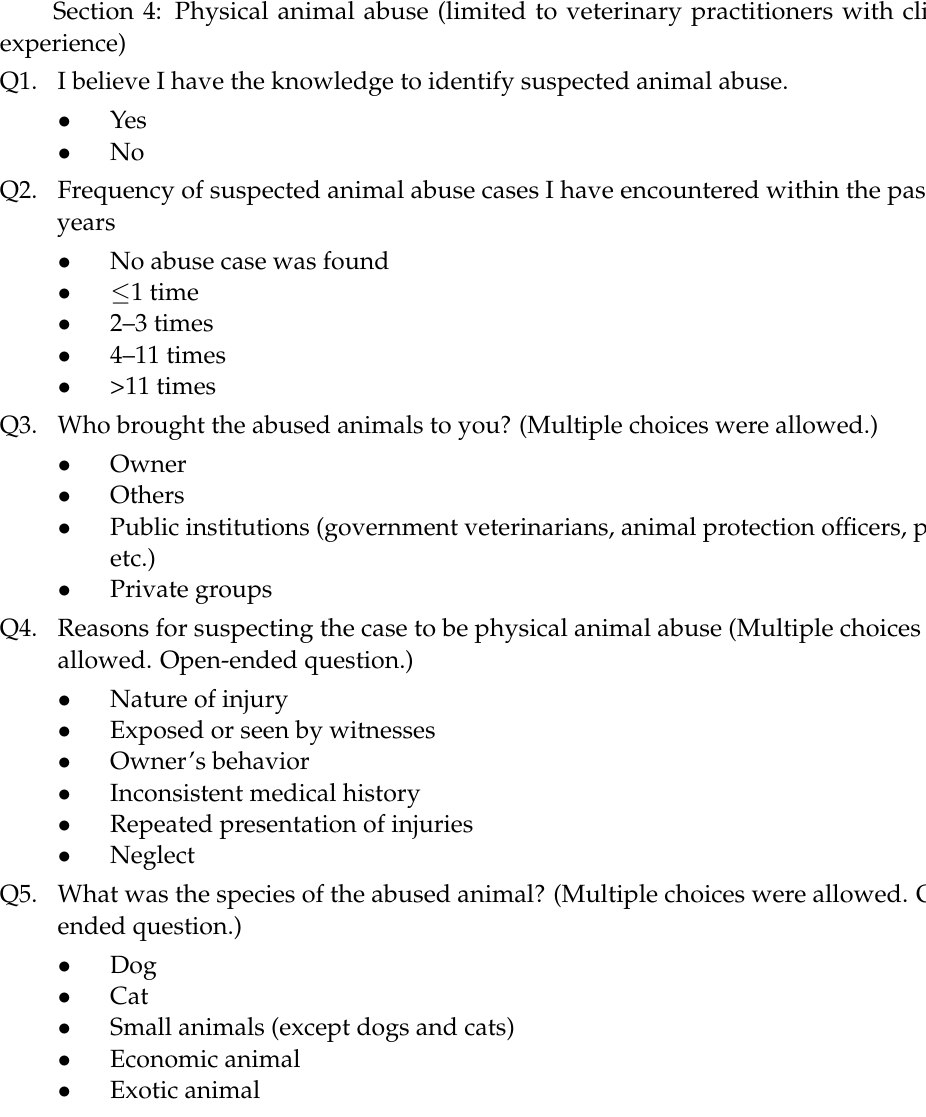
Section 4: Physical animal abuse (limited to veterinary practitioners with clinical